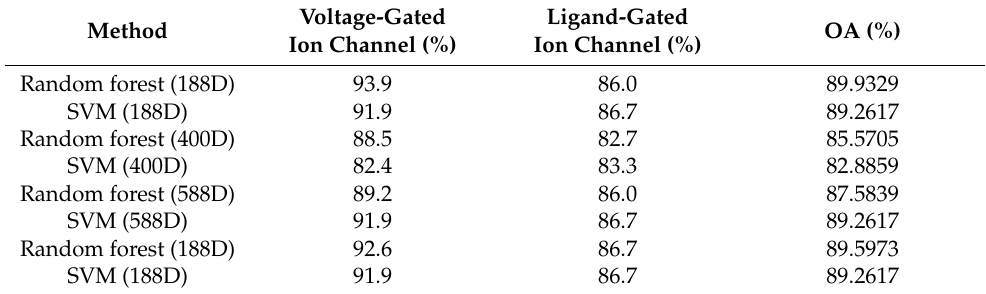
Table 4. Compare the results of the voltage-gated ion channels with that of the ligand-gated ionchannels.